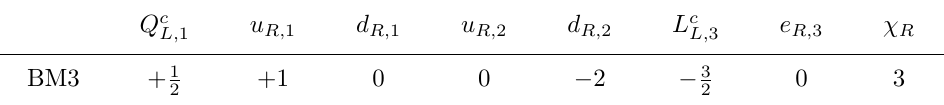
Table 1. The benchmark model BM3 with only one addtional Weyl fermion and first-generation quarks, right-handed second-generation down quarks and third-generation left-handed leptons car- rying U (1) 0